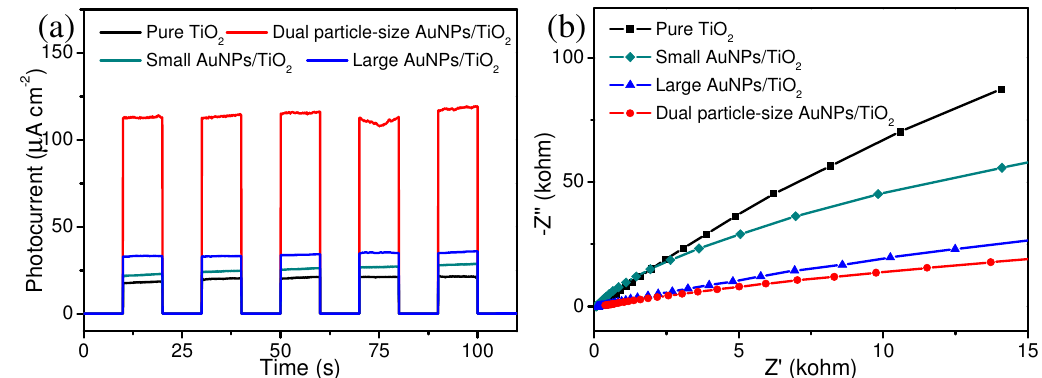
Figure 5. ( a ) Transient photocurrent responses and ( b ) electrochemical impedance spectroscopy Nyquist plots of pure TiO 2 , 0.1 wt% small AuNPs/TiO 2 , 2 wt% large AuNPs/TiO 2 , and 2.1 wt% dual particle-size AuNPs/TiO 2 photocatalysts under light irradiation (350–780 nm).